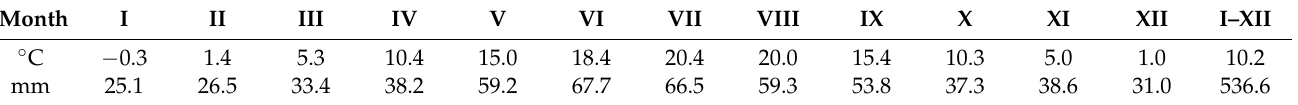
Table 2. Mean monthly precipitation and temperature at the experimental station Groß-Enzersdorf, 1960–2019.